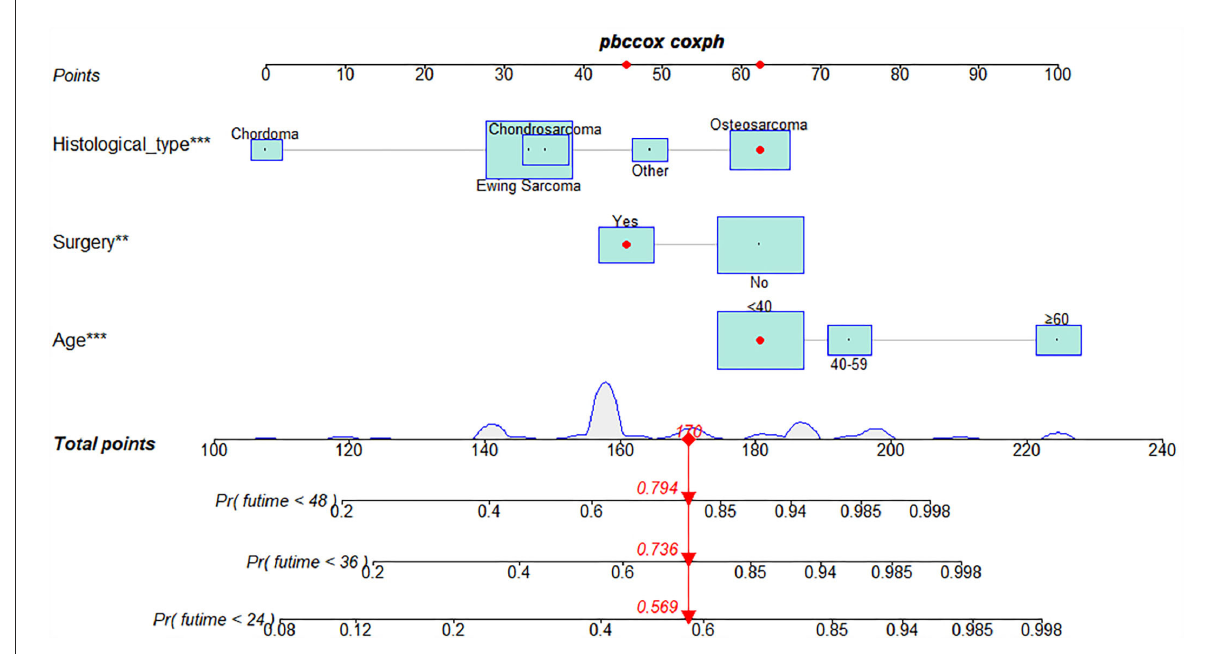
FIGURE8 Prognostic nomogram in predicting 24-, 36-, and 48-month OS for patients with POSNs with DM. *, *** is the value of